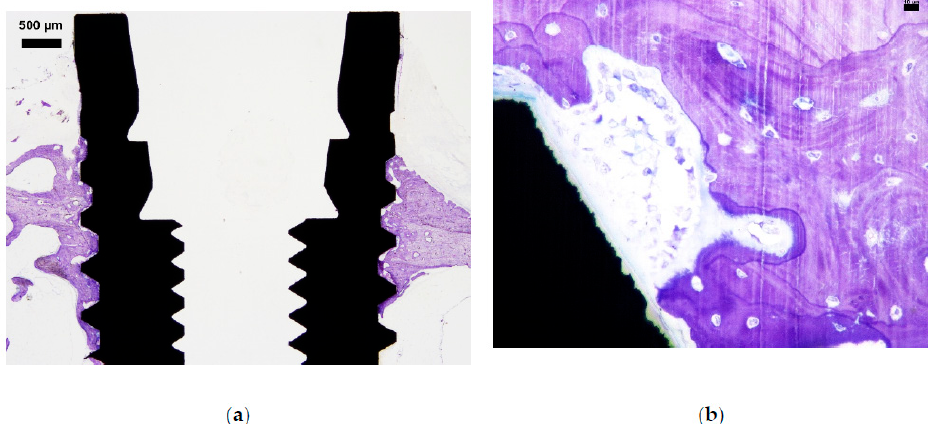
Figure 5. ( a ) A typical example of a control sample (no ligature involved) with darker stained periosteal and endosteal new bone formation. ( b ) This figure illustrates seemingly an ongoing bone remodeling region with clear demarcation between old bone (lighter stained) and younger bone (larger osteocytes and a bit darker stained bone tissue). Possibly some macrophages can be observed in the region closer to the implant.